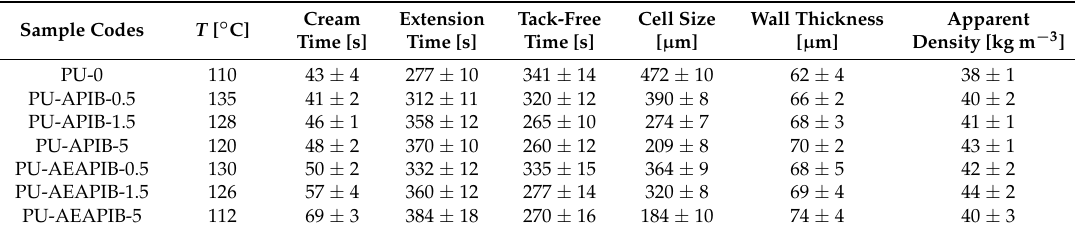
Table 2. Selected properties of